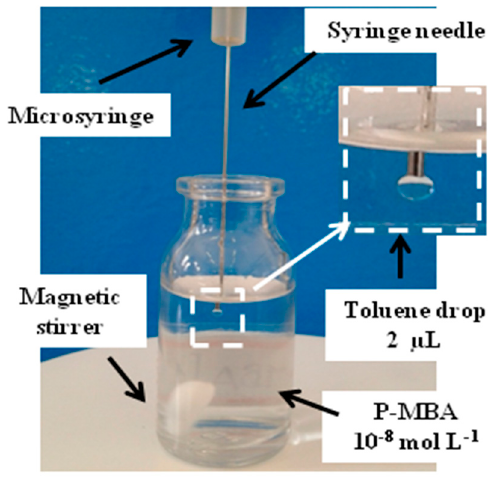
Figure 2. Single-drop microextraction (SDME) experimental setup for microextrations of para -mercaptobenzoic acid ( p -MBA) from a 10 − 8 mol L − 1 solution. In the inset, a detailed photo of the 2 µ L drop extraction solvent (toluene).